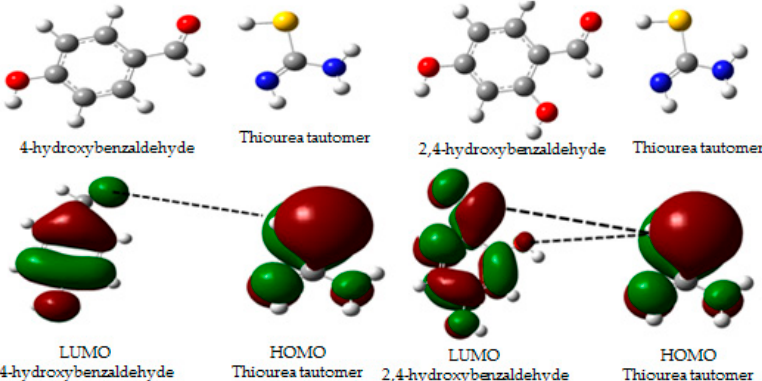
Figure 4. Interactions between the lowest unoccupied molecular orbital (LUMO) of the 4-hydroxybenzaldehyde and 2,4-dihydroxybenzaldehyde compounds and highest occupied molecular orbital (HOMO) of the thiourea tautomer (nucleophile).